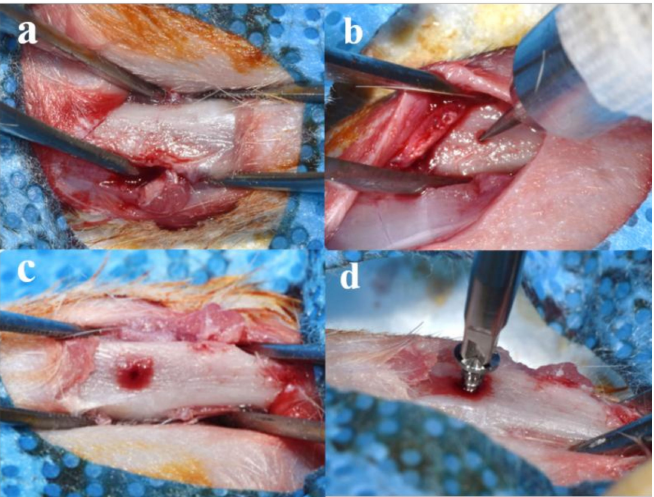
Figure 9. Surgical procedures for installation of collagen coated implant in rat tibia: ( a ) preparation of rat tibia for surgery; ( b , c ) drilling procedures; and ( d ) installation of a randomly assigned implant.